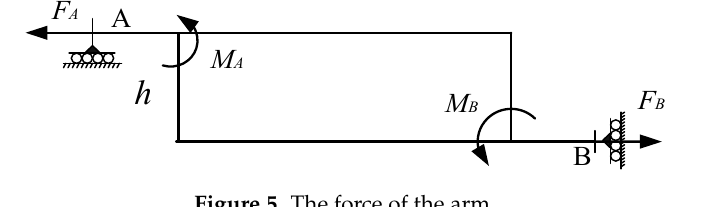
Figure 5. The force of the arm.